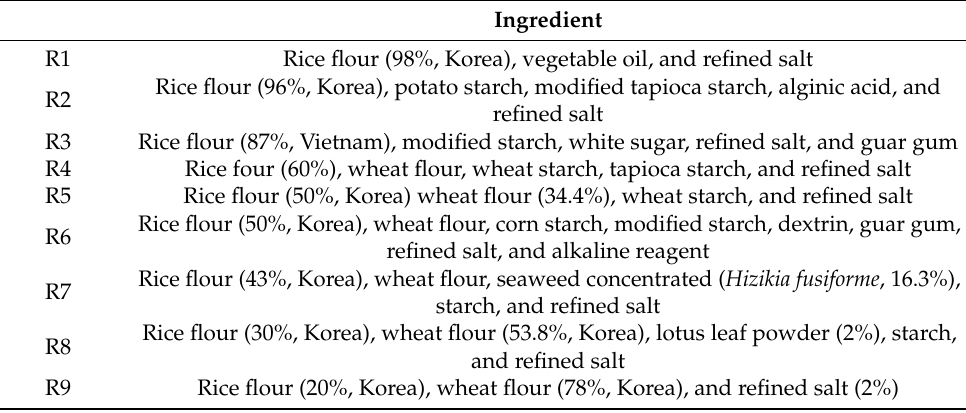
Table 1. Detailed ingredients in rice noodle samples.